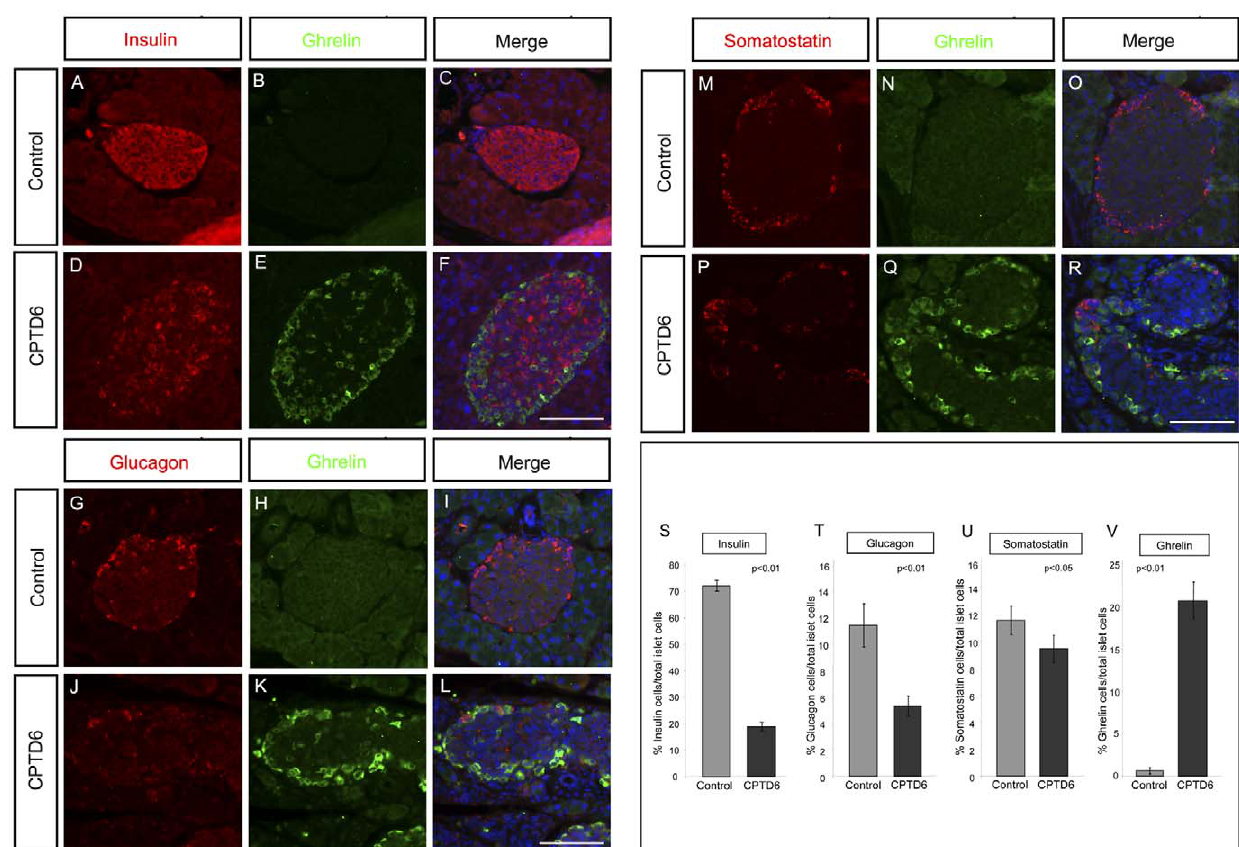
Figure 6. Upregulation of Ghrelin expression in CPTD6 islets. Immunohistochemistry for ghrelin ( B, E, H, K, N, Q ) was performed in combination with insulin ( A , D ), glucagon ( G, J ), and somatostatin ( M, P ). Merged images with DAPI nuclear counter-staining are shown ( C, F, I, L, O, R ) on pancreata from control ( A , B, C, G, H, I, M, N, O ) and CPTD6 ( D, E, F, J, K, L, P, Q, R ) mice. Levels of insulin and glucagon expression are markedly reduced or lost in the majority of islet cells of CPTD6 mice in comparison with the controls, while the number of somatostatin positive cells appears more moderately reduced. Very few, if any, ghrelin positive cells can be found in the islets of control adult mice ( B, C , H, I, N, O ) . In contrast, strong staining is observed in many cells of the CPTD6 pancreata, located predominantly around the periphery of the islets. Images are representative of at least four animals from each group. Scale bars, 50 m m. (S, T, U, V). Quantification of the relative numbers of hormone expressing cells in the islets of Langerhans of control and CPTD6 animals shown as the percentage of immunofluorescence positive cells per total number of DAPI positive cells. (S) Insulin producing cells (control 72% . 19% CPTD6), (T) Glucagon producing cells (control 11.4% . 5.3% CPTD6) (U) Somatostatin producing cells (control 11.6% . 9.5% CPTD6), and (V) Ghrelin producing cells (control 0.6% . 20.6%